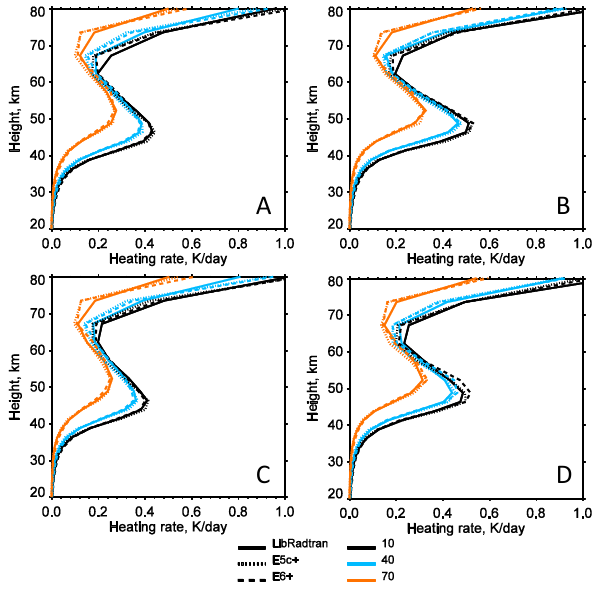
Figure 6. Shortwave heating rate differences (solar max minus solar min) of the 11-year solar cycle in Kday − 1 for four stan- dard atmospheres: (a) midlatitude summer, (b) midlatitude winter, (c) subarctic summer, (d) subarctic winter. Solid lines: libRadtran. Dashed lines: E6 + (E6 including corrections to 120nm). Dotted lines: E5c + . Colours: different solar zenith angles (black 10 ◦ , blue 40 ◦ , orange 70 ◦